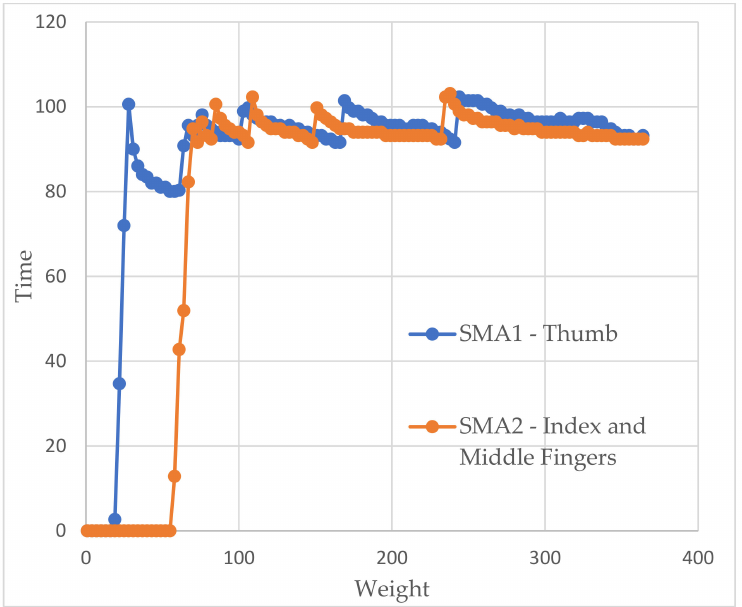
Figure 13. Weight vs time graph for the glove test with a simulated weight of 100 g.